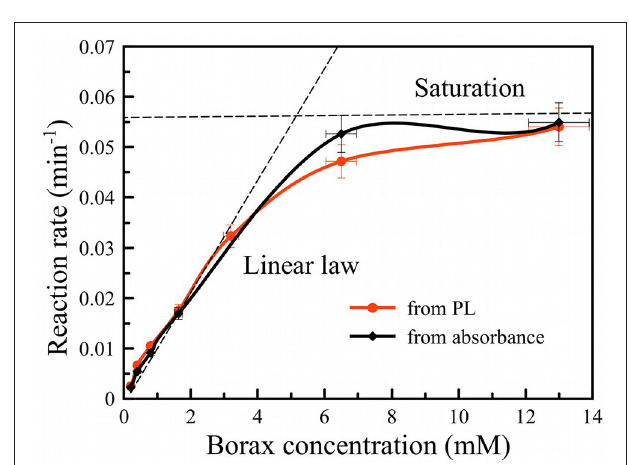
FIGURE 5 | Oxidation rate of PSiNPs vs. borax concentration in suspension obtained from photoluminescence (red curve) and absorbance (black curve) measurements. Dashed line traces are included as a guide to the